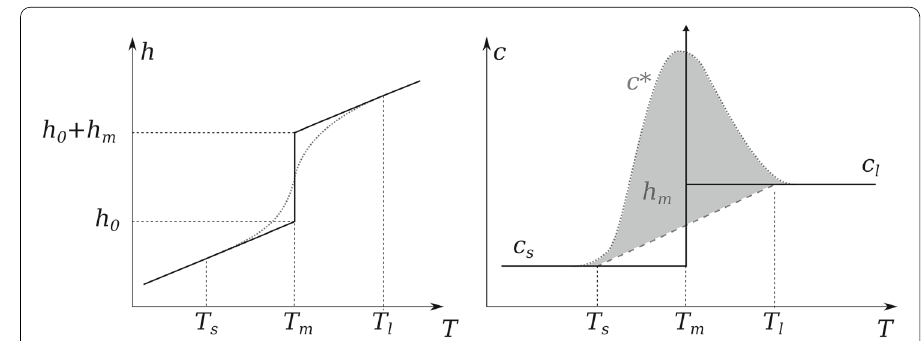
Fig. 1 Left: enthalpy-temperature diagram for isothermal (solid line) and mushy (dotted line) phase change. Right: capacity-temperature diagram shows a singularity for isothermal phase change (solid line) at T m .